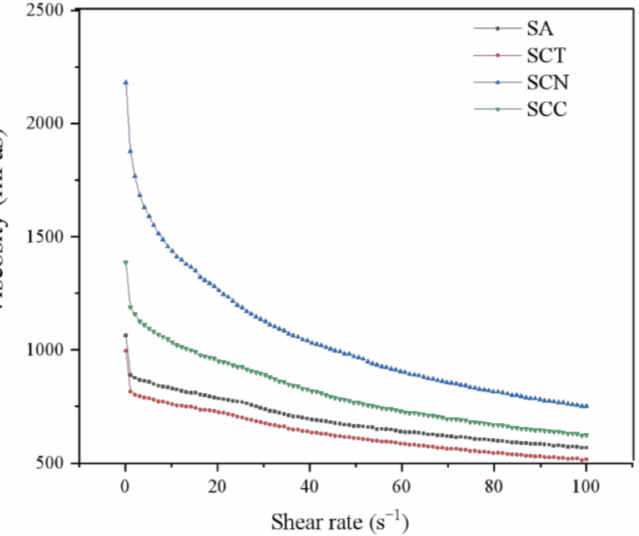
Figure 3. Flow curves of SA (sodium alginate), SCT (SA/CCT), SCN (SA/CN), and SCC (SA/CN/CCT)